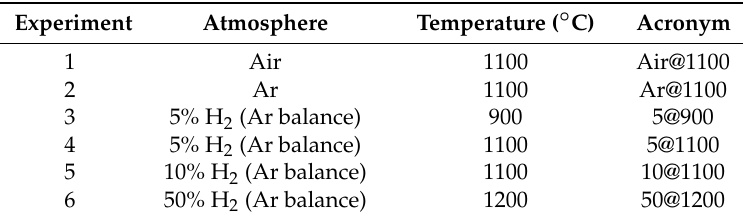
Figure 2. Transmission electron microscopy (TEM) image of 1 . Table 1. Summary of experimental conditions and acronym used herein.